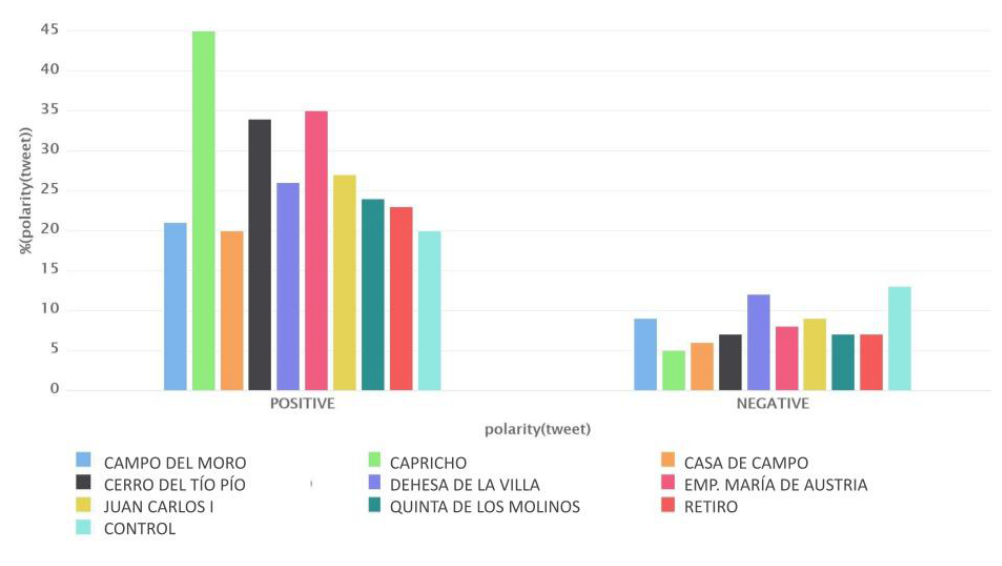
Figure 3. Sentiment analysis of the tweets from Madrid parks in percentages.